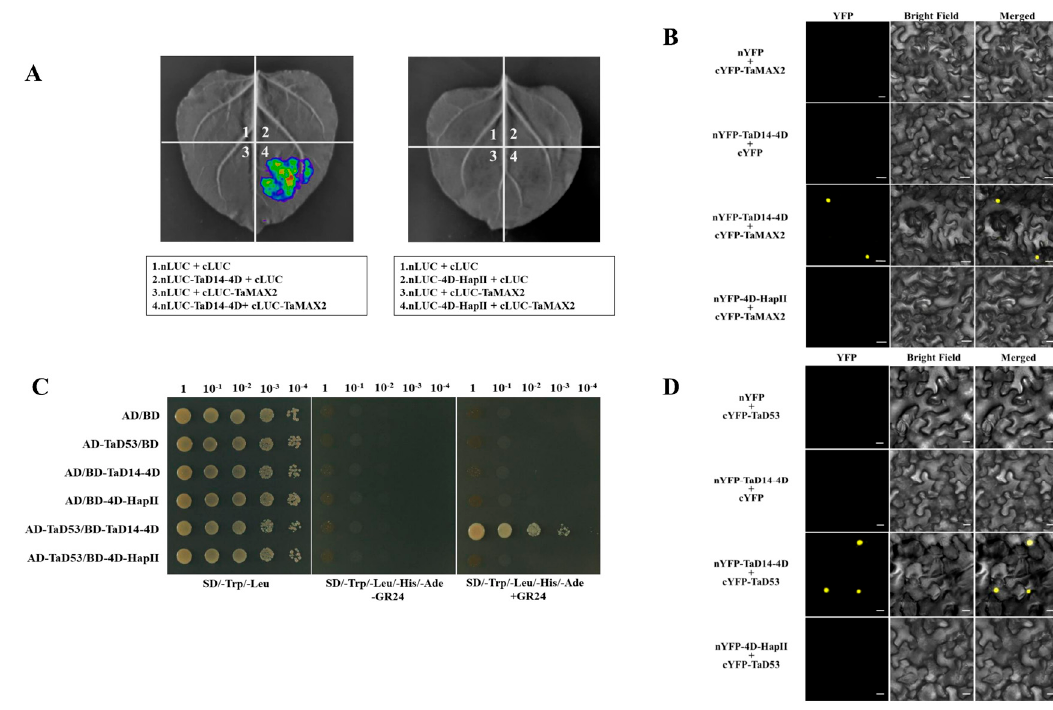
Figure 5. The interactions between TaD14-4D haplotypes and strigolactone pathway members TaMAX2 and TaD53. ( A ) LCI assay showed TaMAX2 interacts with TaD14-4D instead of 4D-HapII. nLUC, N-terminal of LUC; cLUC, C-terminal of LUC. ( B ) BiFC assay showed TaMAX2 interacts with TaD14-4D instead of 4D-HapII. YFP, yellow fluorescent protein. nYFP and cYFP represent the N-terminal and C-terminal of YFP, respectively. BF, bright-field. Scale bars, 20 µ m. ( C ) Yeast two-hybrid assay showed TaD53 interacts with TaD14-4D instead of 4D-HapII. AD, activating domain; BD, binding domain; SD, synthetic dropout medium. Yeast transformants were spotted on the control medium (SD/Trp/Leu, SD lacking Trp and Leu) and selective medium (SD/Trp/Leu/His/Ade, SD lacking Trp, Leu, His, and Ade). The yeast transformants were 10-fold serially diluted and spotted onto the selected medium. ( D ) BiFC assay showed TaD53 interacts with TaD14-4D instead of 4D-HapII. Scale bars, 20 μ m. Three independent tobacco leaves were used for LUC and YFP signal detection.